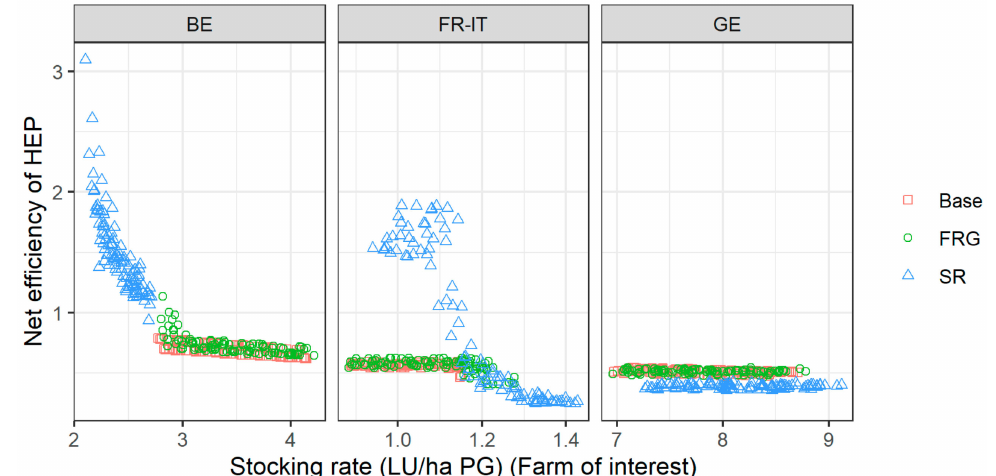
Figure 6. Relation between the net efficiency of HEP production and the stocking rate in livestock unit (LU) per ha of permanent grassland (PG) in the farm of interest for the tested scenarios for the baseline (Base) and in the fast rotational grazing (FRG) and system redesign (SR) scenarios applied to the Belgian (BE), French–Italian (FR-IT), and German (GE) case